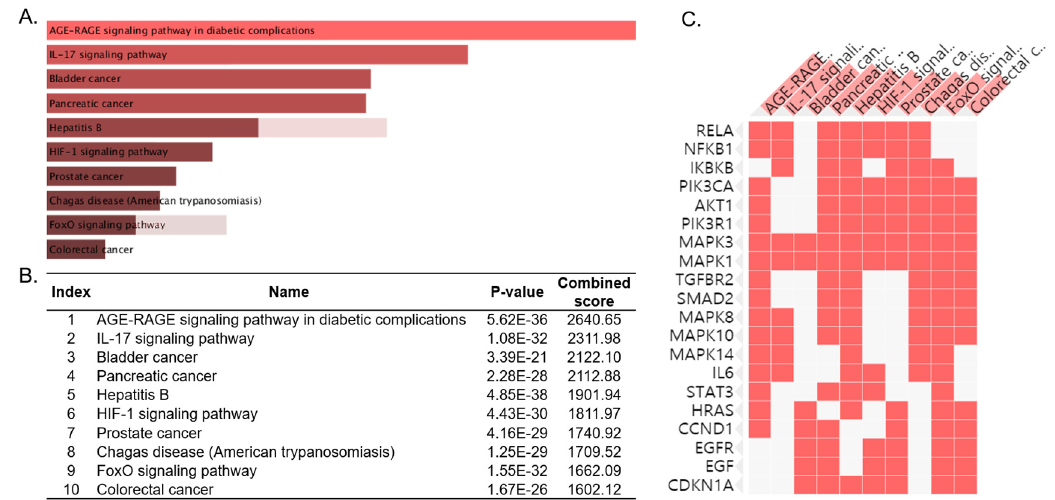
Figure 2. Functional enrichment analysis of the LJ network, with combined scores in descending order. ( A ) Bar graph showing the pathways and their combined scores. ( B ) Pathways detailed with p -values and combined scores. ( C ) A clustergram of related genes.